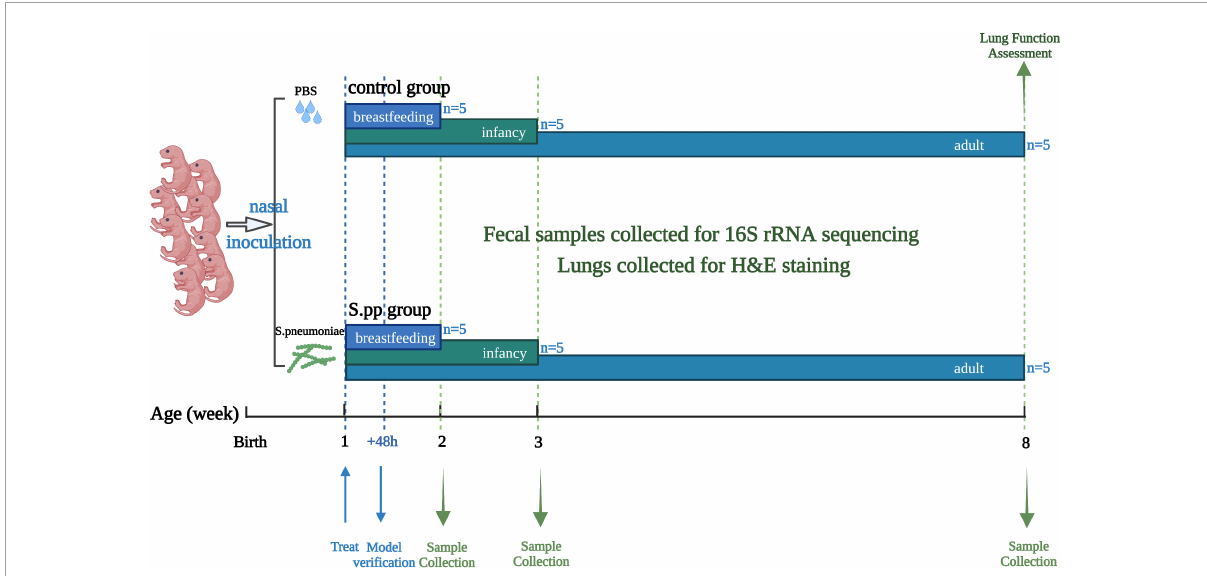
FIGURE1 Experimental design and sample-collection time. In brief, mice were intranasally instilled with PBS (Control) or Streptococcus pneumoniae (S.pp) at 1 week of age, and a lung homogenate was used for model verification 48 h post-infection. Fecal and lung samples were collected at 1 wpi (breastfeeding period), 2 wpi, (infancy), and 7 wpi, (adulthood) for 16S rRNA sequencing and H&E staining, lung function were assessed in